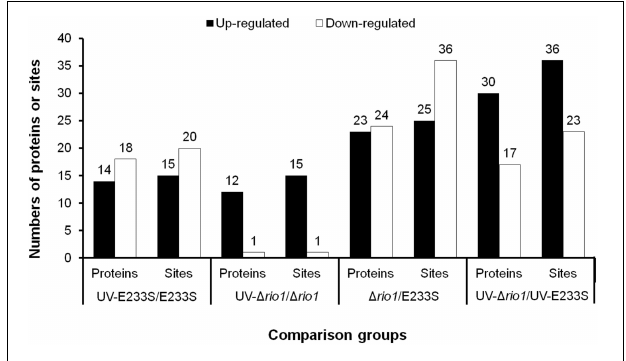
FIGURE 3 | Statistics of differentially phosphorylated protein sites in various comparison groups. The numbers of phosphorylated proteins (sites) with a threshold of > 1.3-fold are summarized here. The increased (up-) and decreased (down-) amount of phosphorylated proteins and sites are shown in filled and empty bars,